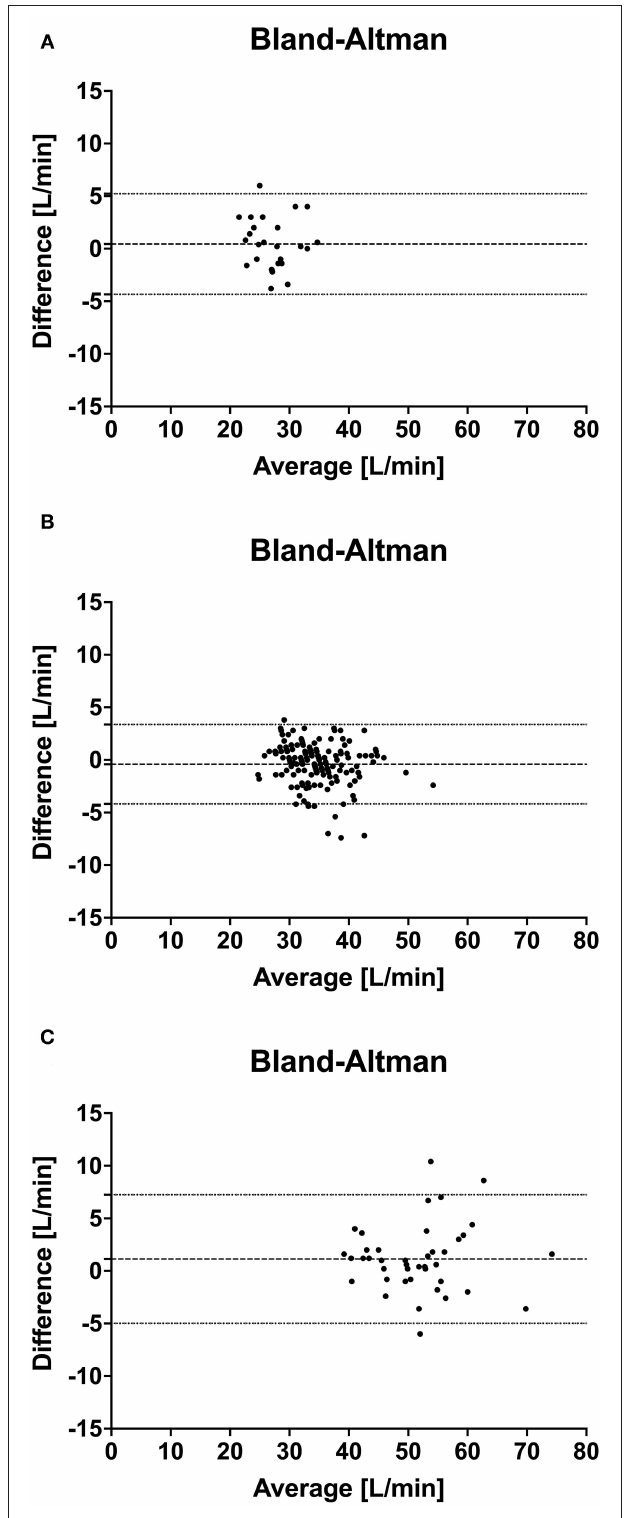
FIGURE 4 | Bland Altman analysis of simultaneous cardiac output measurements using thermodilution (TDCO) and bioreactance (NICOM) in 6